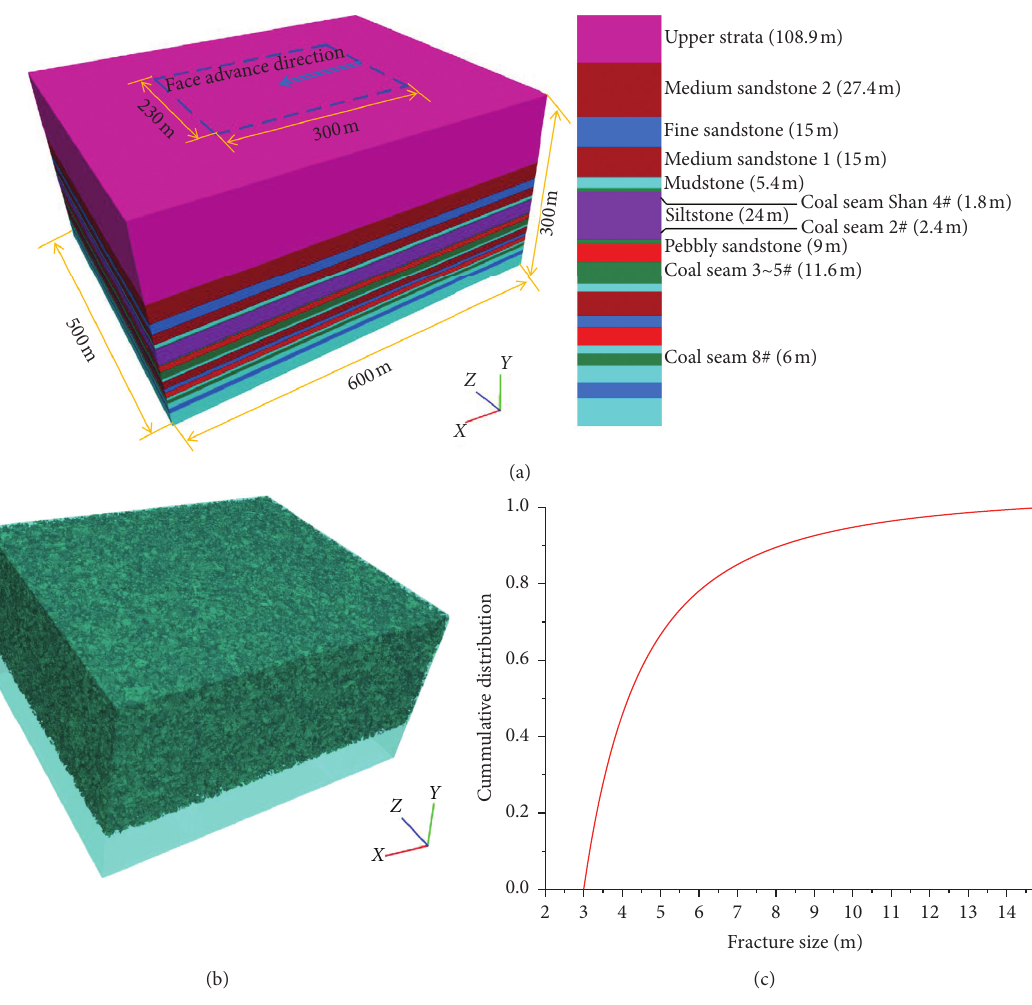
Figure 4: Established numerical simulation model of the 8212 working panel: (a) 3D numerical simulation model, (b) DFN generated in coal seam and overburden rock strata, and (c) size distribution of DFN from a power law distribution. Table 2: Physical and mechanical properties of the